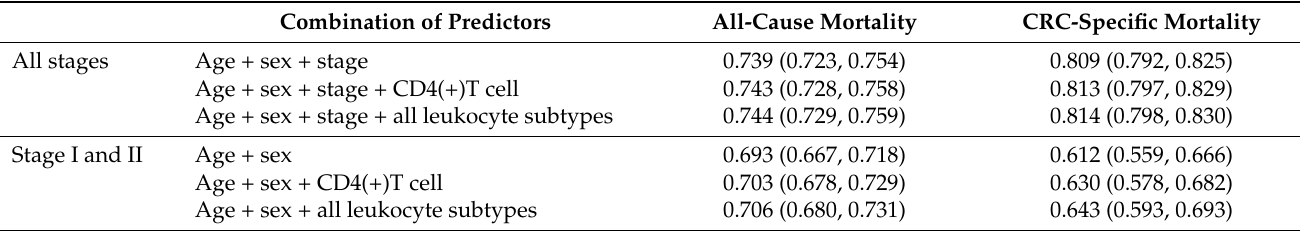
Figure 3. Survival curves for CRC patients across quartiles of CD4+ T cell proportions by tumor stage. ( A ) Overall and ( B ) CRC-specific survival curves among stage I and II patients; ( C ) overall and ( D ) CRC-specific survival curves among stage III patients; ( E ) overall and ( F ) CRC-specific survival curves among stage IV patients. Note: Survival curves were adjusted for age, sex, tumor subsite, timing of blood sampling and batch. p values were derived from G-rho family of tests. Quartile 1: lowest quartile; Quartile 4: highest quartile. Table 2. Harrell’s C-statistics (95% confidence interval) for all-cause mortality and colorectal cancer (CRC)-specific mortal- ity